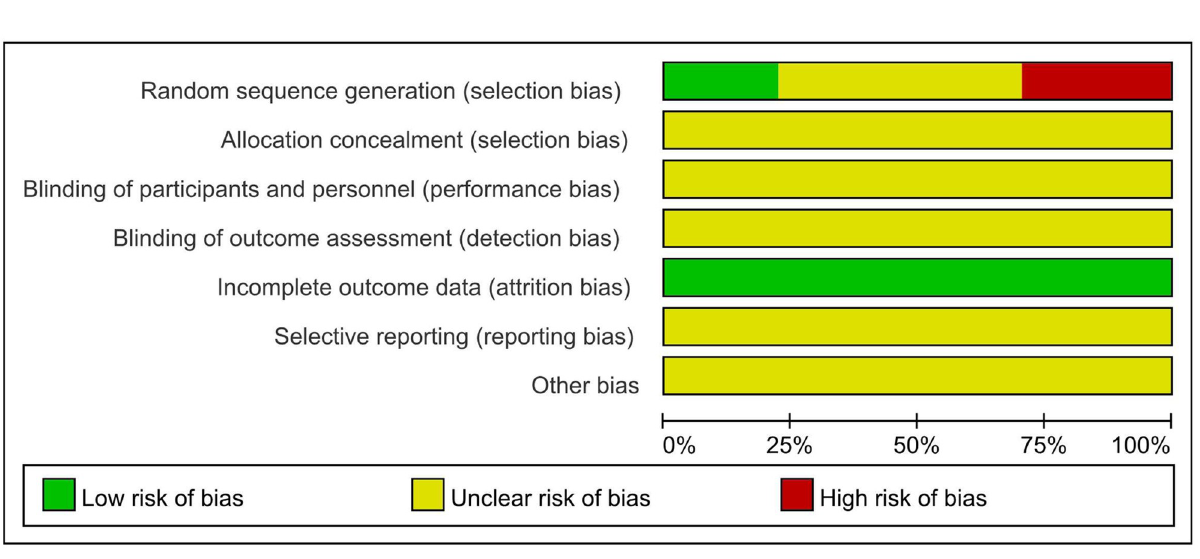
Fig 2. Assessment of risk of bias.